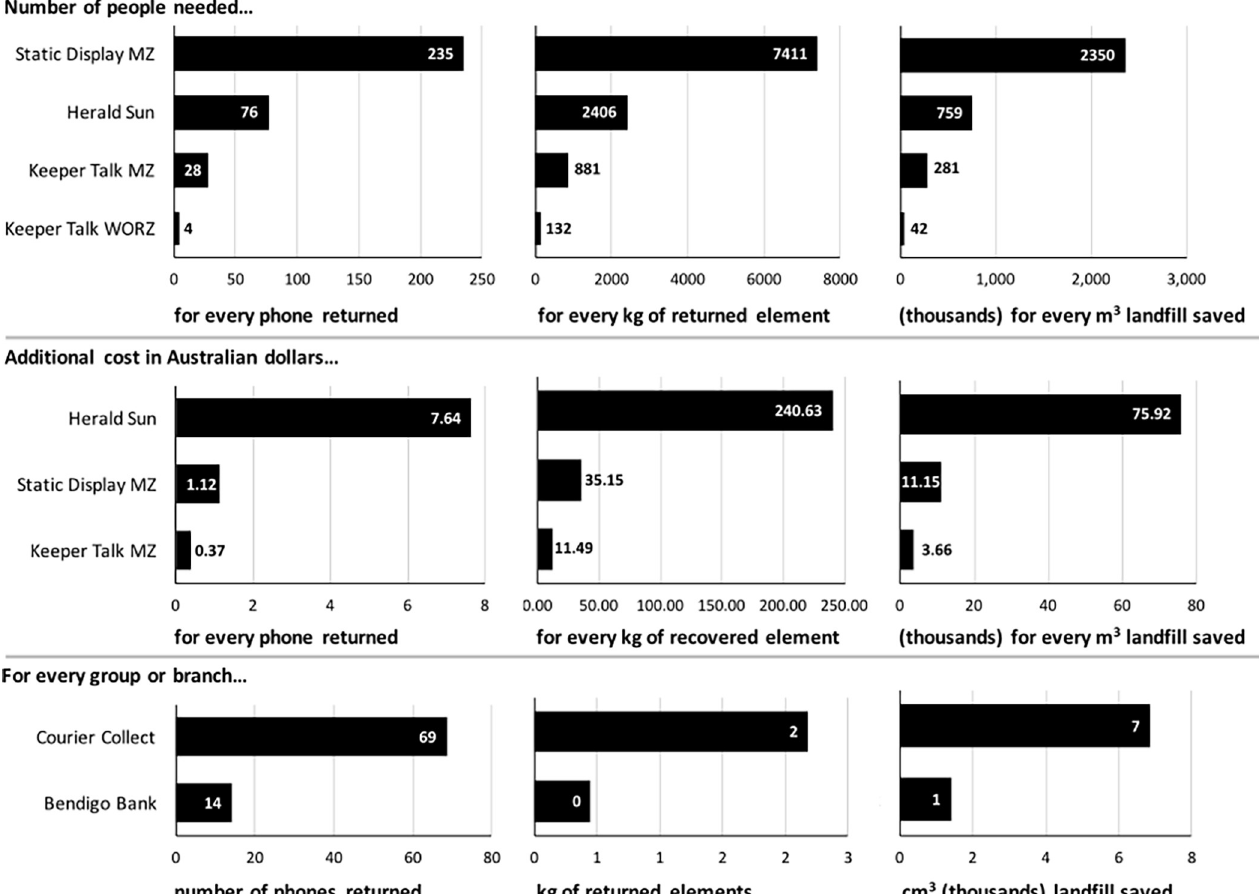
Fig 5. Example methods for comparing Points of Influence. Upper Panel : Comparison by estimated number of people required to collect each phone [people( n )/phones( n )], each kilogram (kg) of returned elements [people( n )/elements(kg)], and every cubic meter (m 3 ) of landfill saved [people( n )/landfill(m 3 )]. Middle Panel : Comparison by estimated additional cost (i.e. above normal operations) in Australian dollars (AUD) required to collect each phone [AUD/ phones( n )], each kilogram (kg) of recovered elements [AUD/elements(kg)], and every cubic meter (m 3 ) of landfill saved [AUD( n )/landfill(m 3 )]. Lower Panel : Comparison of number of phones [phones( n )/groups( n )], kg of recovered elements [elements(kg)/groups( n )], and m 3 of landfill saved [landfill(m 3 )/groups( n )] for every community group or bank branch. Estimations provided are dependent on available data and are calculated from information provided in Table 1 and Supporting Information (S5